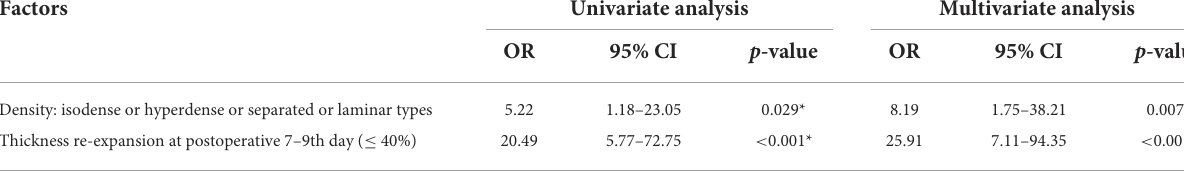
TABLE 4 Univariate and multivariate analysis of factors related to CSDH recurrence ( n = 295). Factors